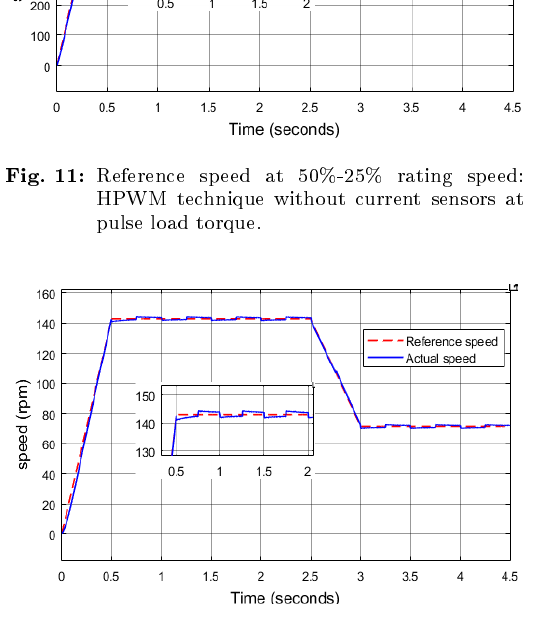
Fig. 12. Reference speed at 10%-5% rating speed: HPWM technique without current sensors at pulse load torque.